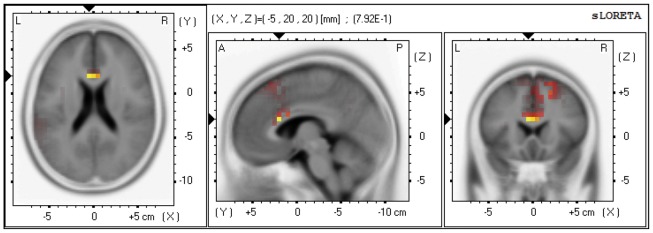
sLORETA solutions on P3 temporal factor scores showing voxels in which the Nogo>Go contrast was significant (p<0.01).